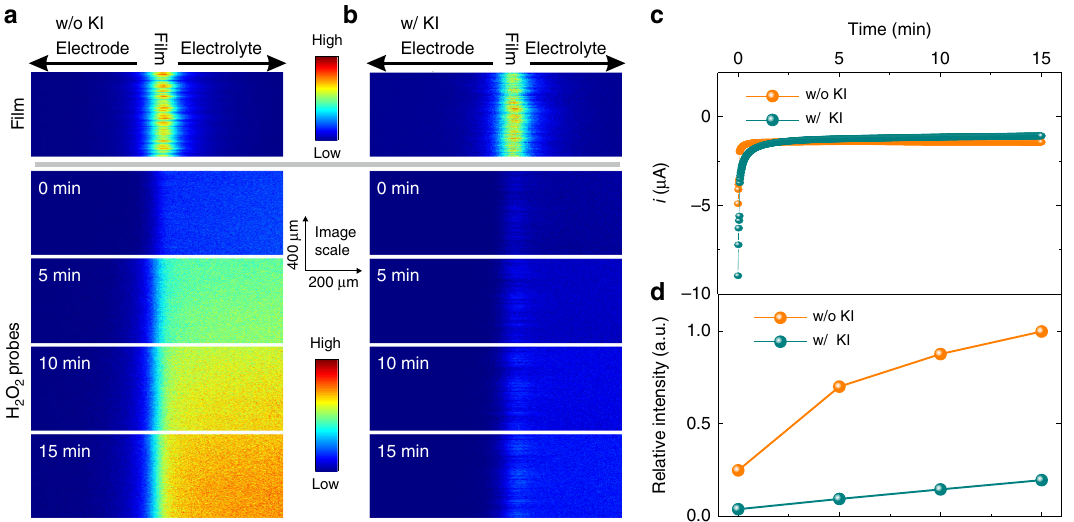
Fig. 2 Detection of H 2 O 2 using confocal fl uorescence microscopy. Representative fl uorescent depth pro fi le images of the viologen-modi fi ed fi lms (top panel) at open circuit potential (OCP) and of H 2 O 2 -sensitive indicators (lower panels: 0 – 15 min) at a constant potential of − 0.1 V vs SHE a in the absence and b in the presence of KI (0.1 M). c O 2 -reduction current in absence and presence of KI (0.1 M) at constant potential of − 0.1 V vs SHE. d The relative intensity of fl uorescent H 2 O 2 reporter, derived from a and b , normalized to the maximum value. An overlay plot of the depth pro fi le of the fl uorescence of the viologen and of the fl uorescence of the H 2 O 2 -sensitive indicators is given in Supplementary Fig. 5 for better visualization of their respective positions. For all measurements, the glassy carbon electrodes (GCE, 3 mm in diameter) were coated with viologen-modi fi ed polymer with a surface coverage of 2.2 mg cm − 2 . Electrolyte: 2 ml PB (0.1 M, pH 7) with 10 µ L stock solution of Amplite ™ Fluorimetric Hydrogen Peroxide Assay Kit. The fl uorescence of the oxidized viologen-modi fi ed fi lms was collected around its maximum emission of 590 nm upon excitation at 488 nm. The emission of the H 2 O 2 fl uorescent probe was determined around its maximum emission of 660 nm upon excitation at 633 nm. The scale is the same for all images. All measurements were performed under ambient air and at 300 (Supplementary Fig. 4). Distinction between the matrix-based fl uorescence and the fl uorescence originating from the H 2 O 2 reporter was made possible by measuring at different excitation and emission wavelengths, namely 488 nm excitation and 500 – 630 nm emission for viologen mapping, and 633 nm exci- tation and 640 – 750 nm emission for H 2 O 2 monitoring. The presence of potassium iodide (KI) did not affect the absorption or emission spectra of either the H 2 O 2 -sensitive probe or the vio- logen moiety (Supplementary Fig. 4).